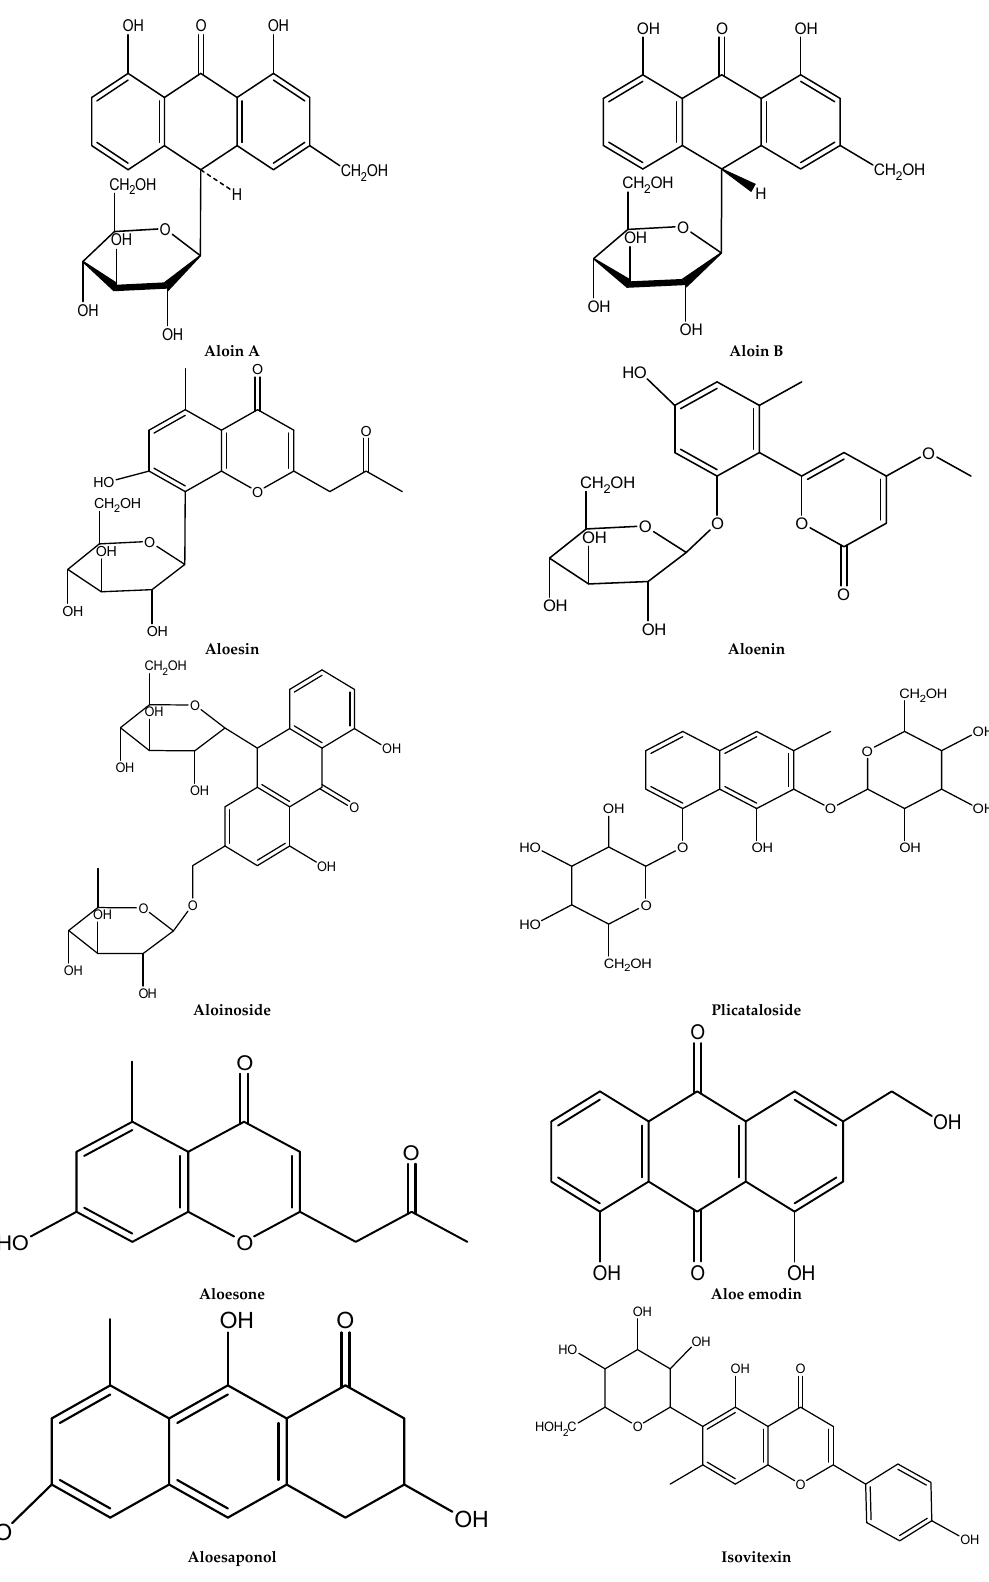
Figure 1. The chemical structures of the main phytochemicals of Aloe species.